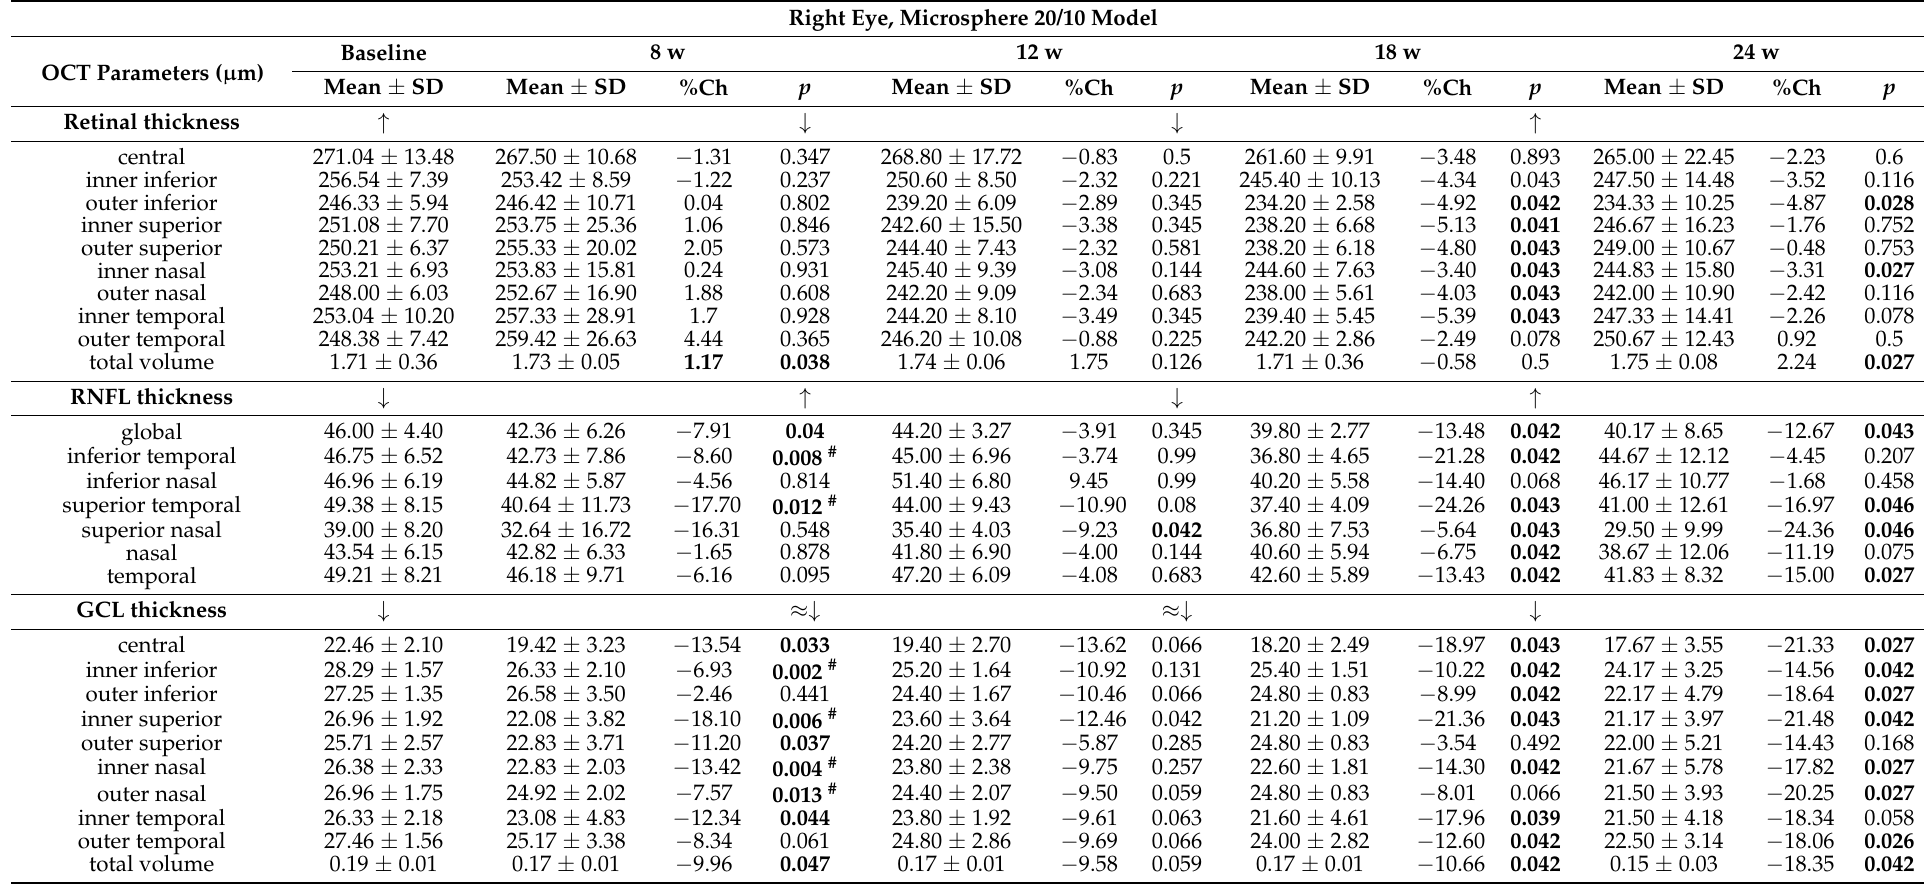
Table 1. Structural analysis of right-eye neuroretina by optical coherence tomography (OCT) (Ms20/10